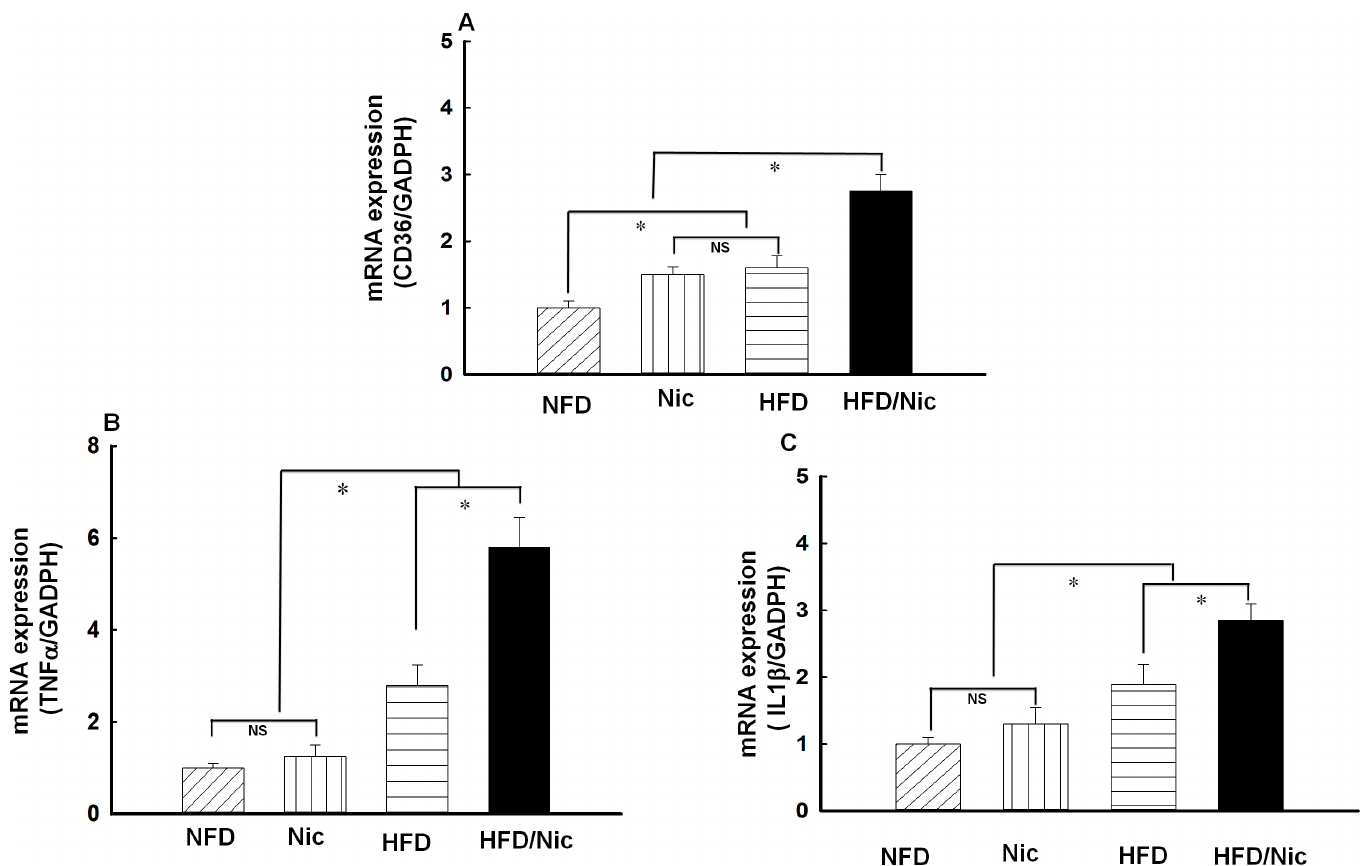
Fig 4. The mRNA expressions of CD36 (A), TNF α (B) and IL1 β (C) in the peritoneal macrophages of nicotine-treated obese rats. The mRNA expressions of TNF α , IL1 β and CD36were significantly increasedin the peritonealmacrophages of diet-inducedobeserats. Nicotinefurther increasedthe mRNA expressions of three moleculesin obese(HFD) rats and the mRNA expressionof CD36in lean rats. N = 5, * p < 0.05,vs. NFD, #p < 0.05,vs. HFD.